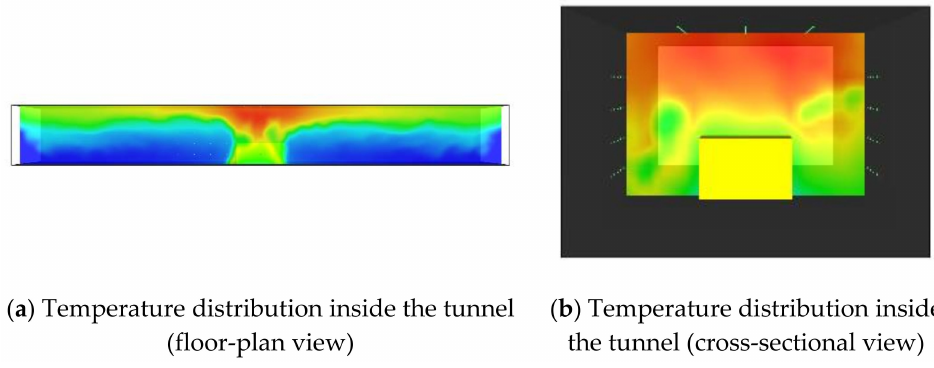
Figure 8. Temperature distribution inside the tunnel.